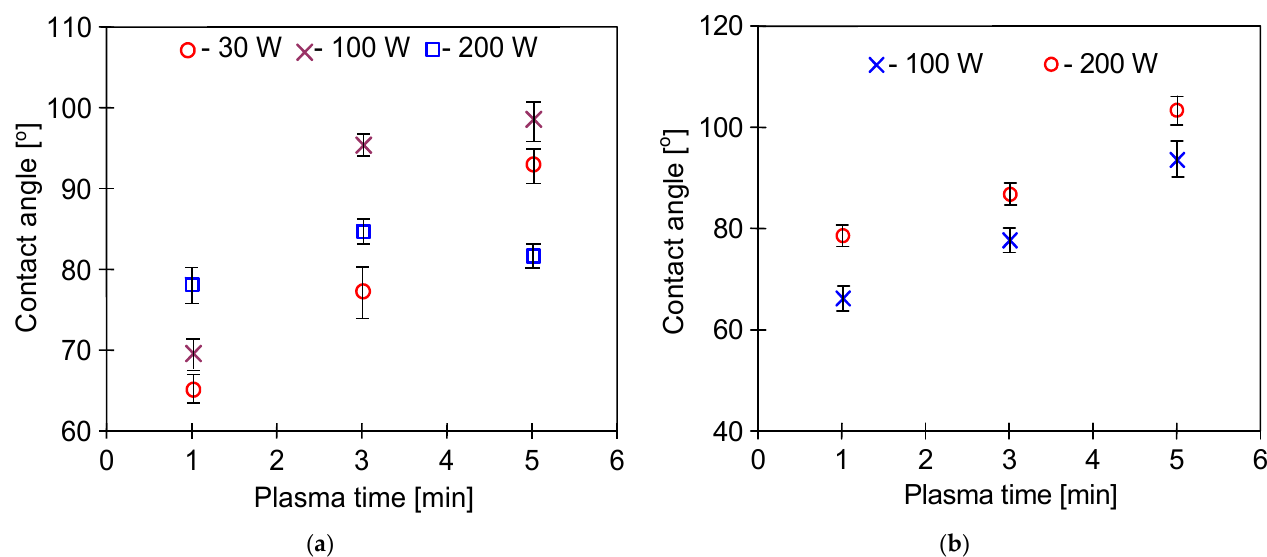
Figure 4. Effect of Ar/O 2 plasma power on the contact angle of PP foil: ( a ) gas plasma: Ar 80% and 20% O 2 . Flow rate: 90 mL/min; ( b ) gas plasma: Ar 50% and 50% O 2 , flow rate: 90 mL/min.